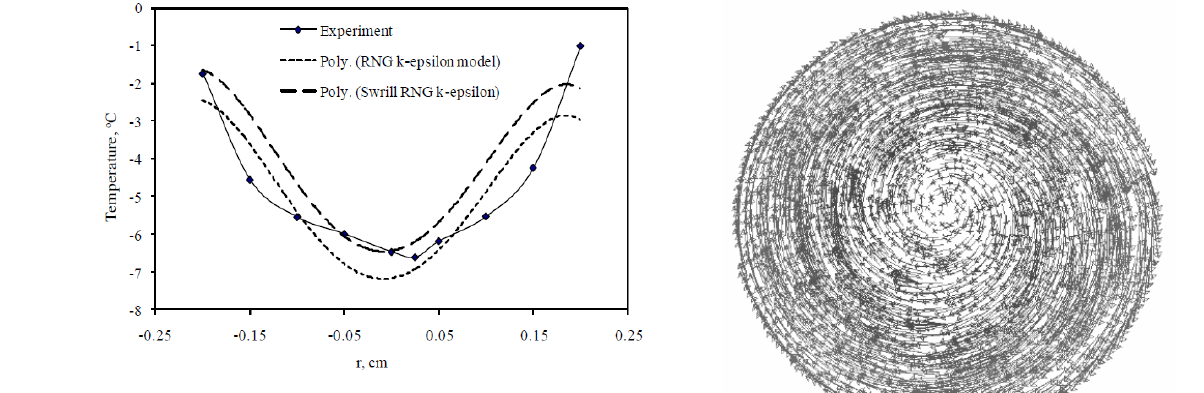
Figure 7. Experimentally measured and predicted static tempera- ture distribution as a function of radius towards cold end at axial position of 0.15 cm at 3 bar inlet pressure.